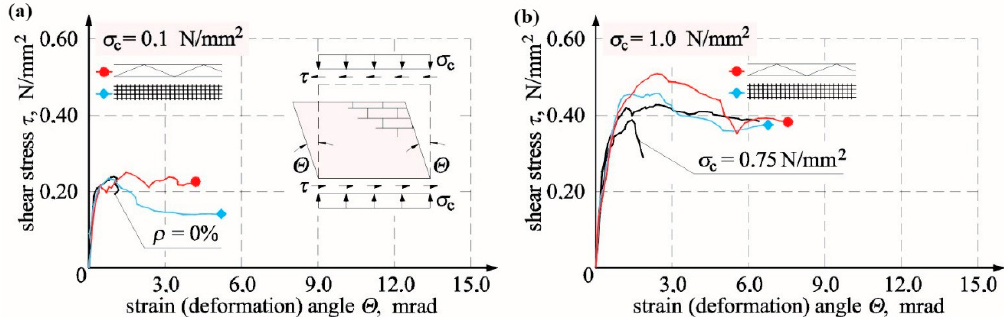
Figure 14. Relationships τ v,i - Θ i for unreinforced and reinforced AAC masonry tested at different values of initial compressive stress: (a) σ c = 0.1 N/mm 2 and (b) σ c = 1.5 N/mm 2 .